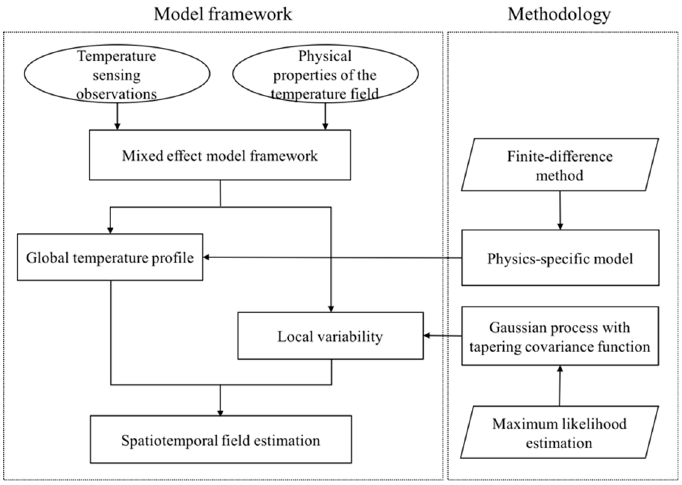
Figure 2. The framework of our methodology.